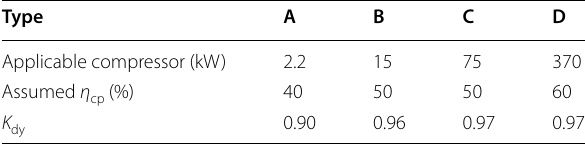
of some refrigeration dy